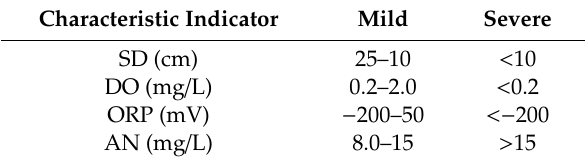
Table 1. Classification standard of the pollution levels of urban black-odor